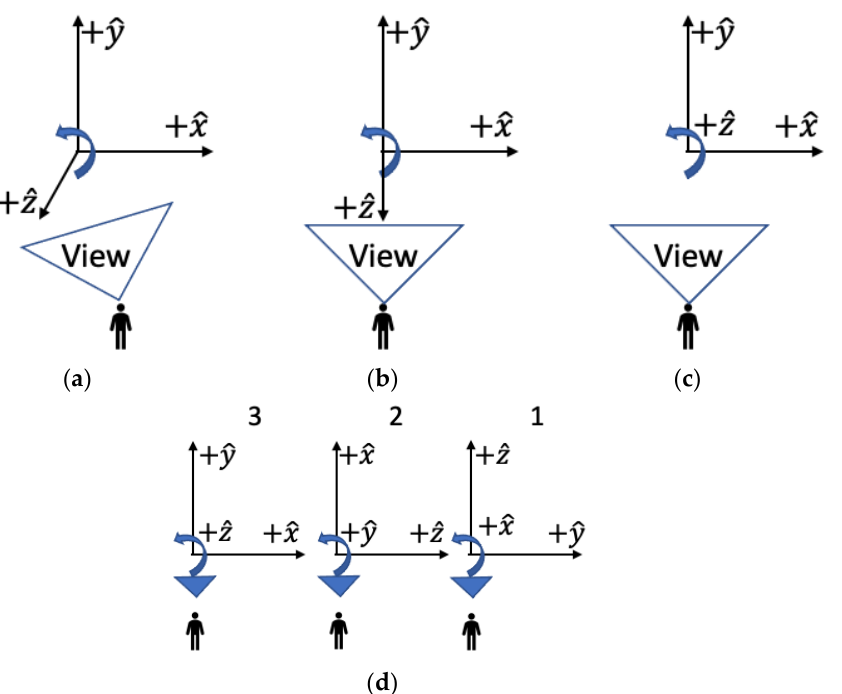
Figure 6. ( a – c ) Transformation from a three-dimensional view of a rotation to a two-dimensional